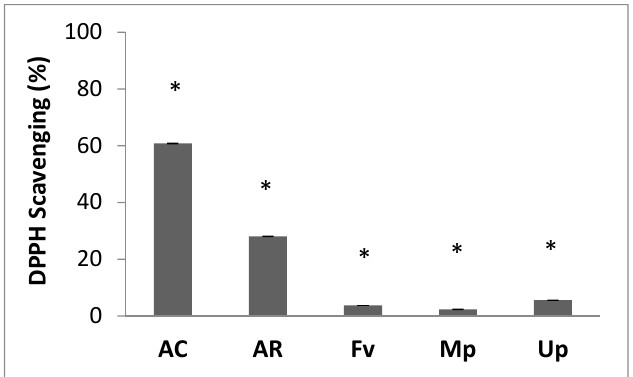
Figure 1. The DPPH radical scavenging power of the S. incisifolium aqueous extracts (AC and AR), and fucoidans from F. vesiculosus (Fv), M. pyrifera (Mp) and U. pinnatifida (Up). * p < 0.05. AC: Aqueous extract subjected to organic solvent partitioning. AR: simple aqueous extraction.